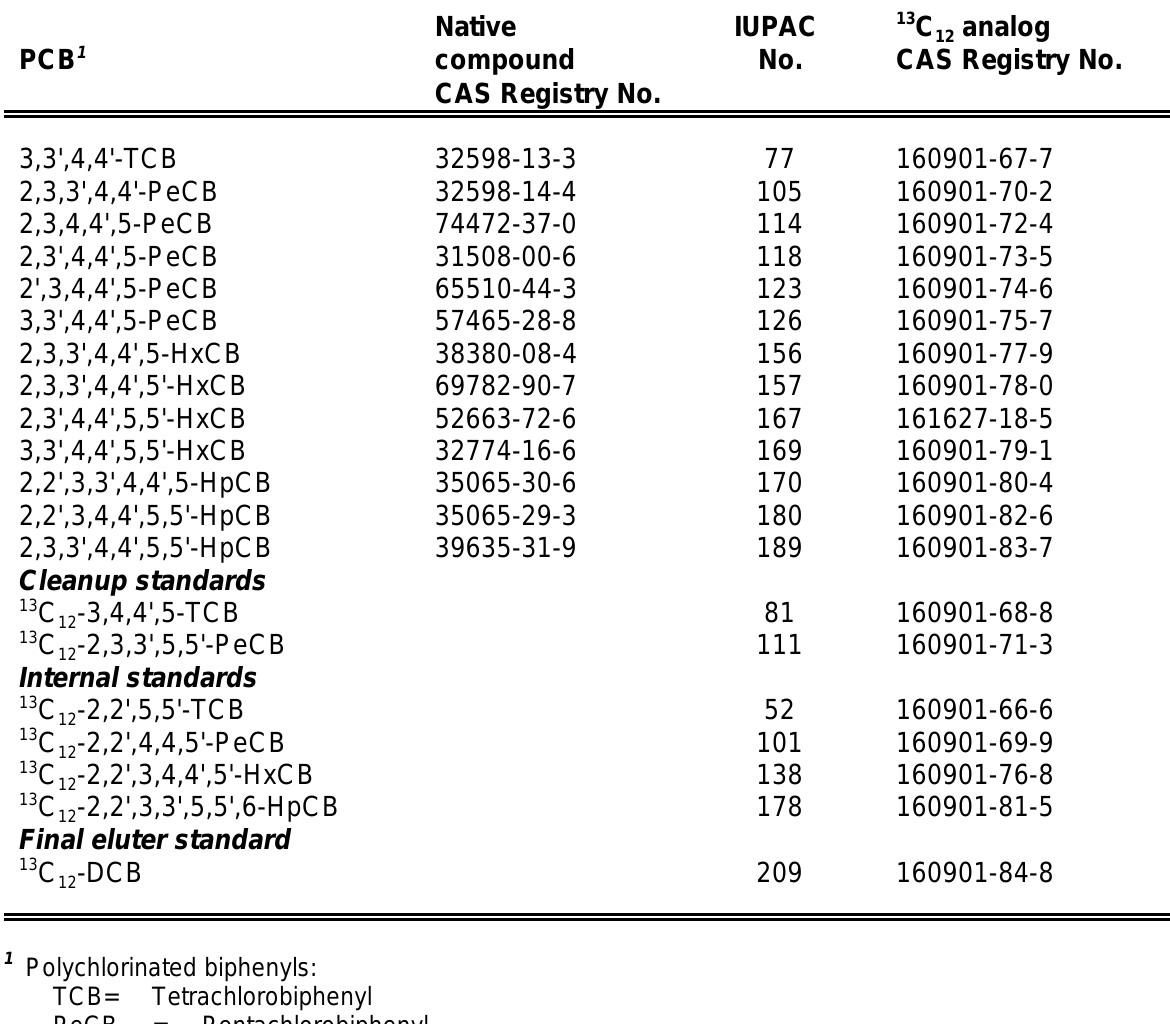
13 C IUPAC analog 12 No. CAS Registry